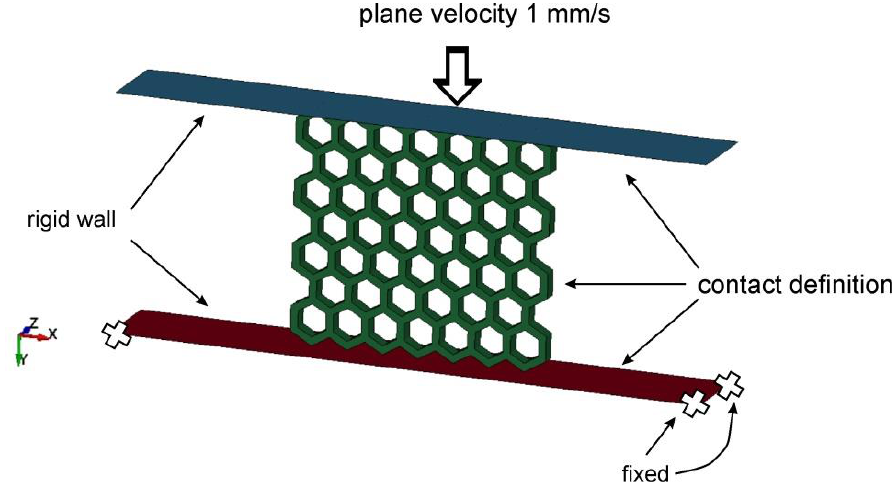
Figure 21. The main boundary conditions adopted for the numerical simulations to reproduce the experimental